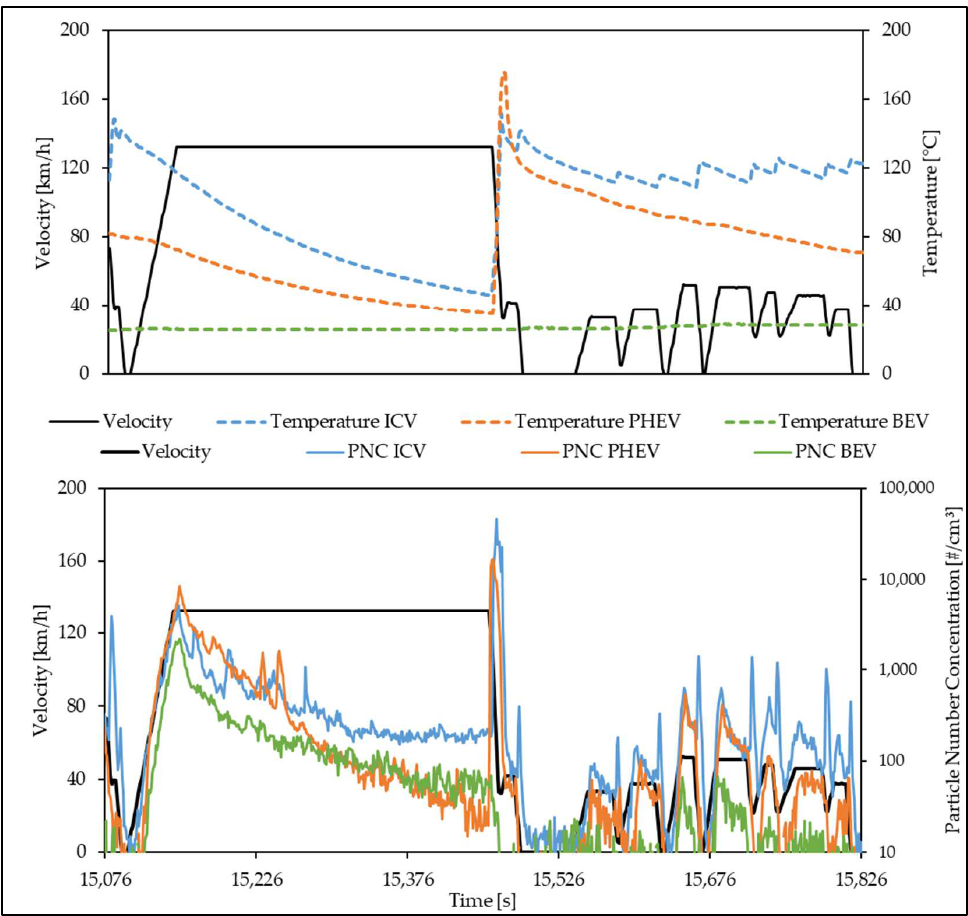
Figure 17. Evolution of temperatures and particle number concentrations (SPN measured with CPC) in comparison between ICV, PHEV, and BEV at the end of WLTP Brake Cycle Trip 10.